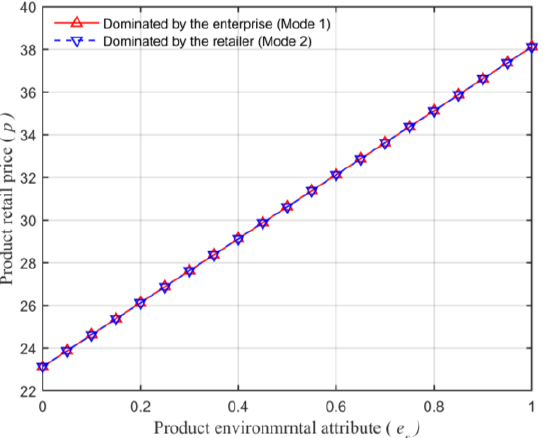
Figure 4. The relationship between the product environmental attribute and the product’s wholesale price.